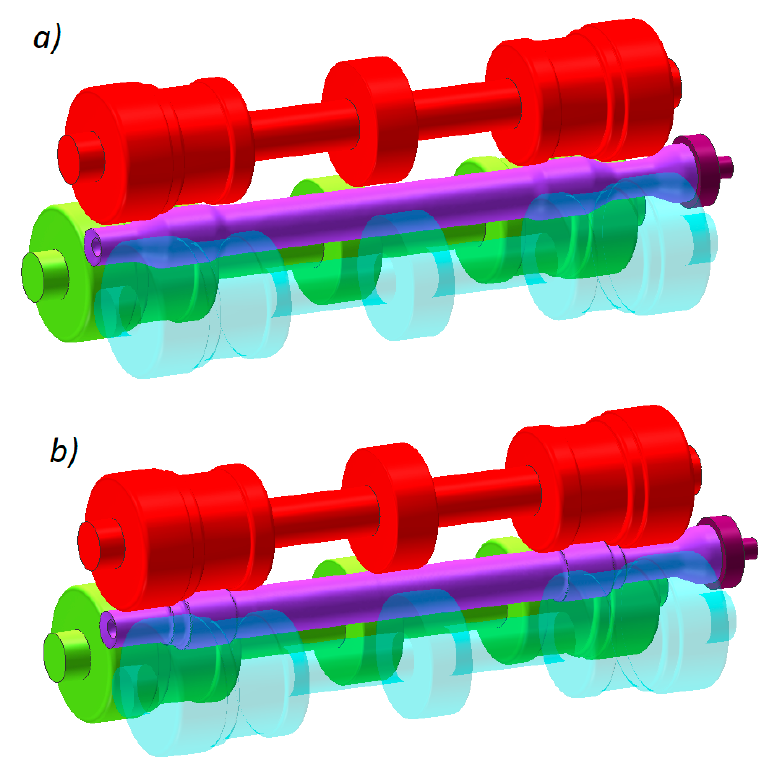
Figure 21. Calibration of a hollow railway axle by rotary compression: ( a ) beginning of the process, ( b ) end of the process.